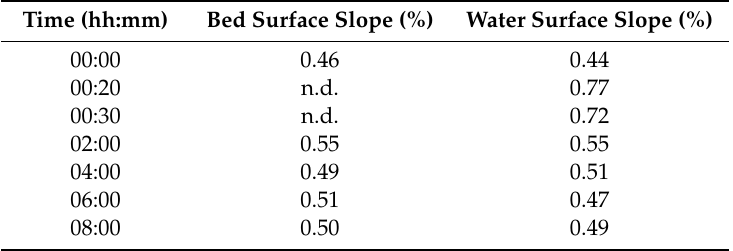
Table A1. Mean slopes of the measured bed surface levels and water surface levels for test run E1, n.d. = not